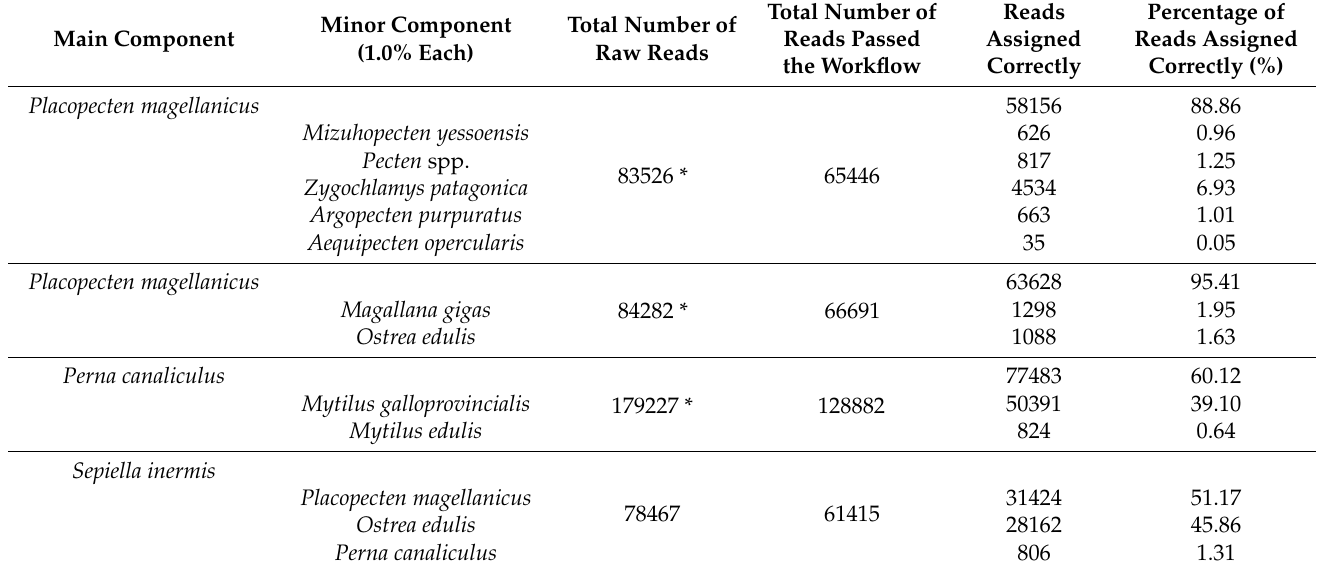
Table 5. Results for DNA extract mixtures representing one bivalve family. DNA from minor components was present in a proportion of 1% each. In addition, results for a DNA extract mixture containing DNA from a squid species ( Sepiella inermis ) as main component (97.0%) and DNA from three bivalve species (1% each) is shown. Numbers are mean values ( n = 9, three sequencing runs, three replicates per